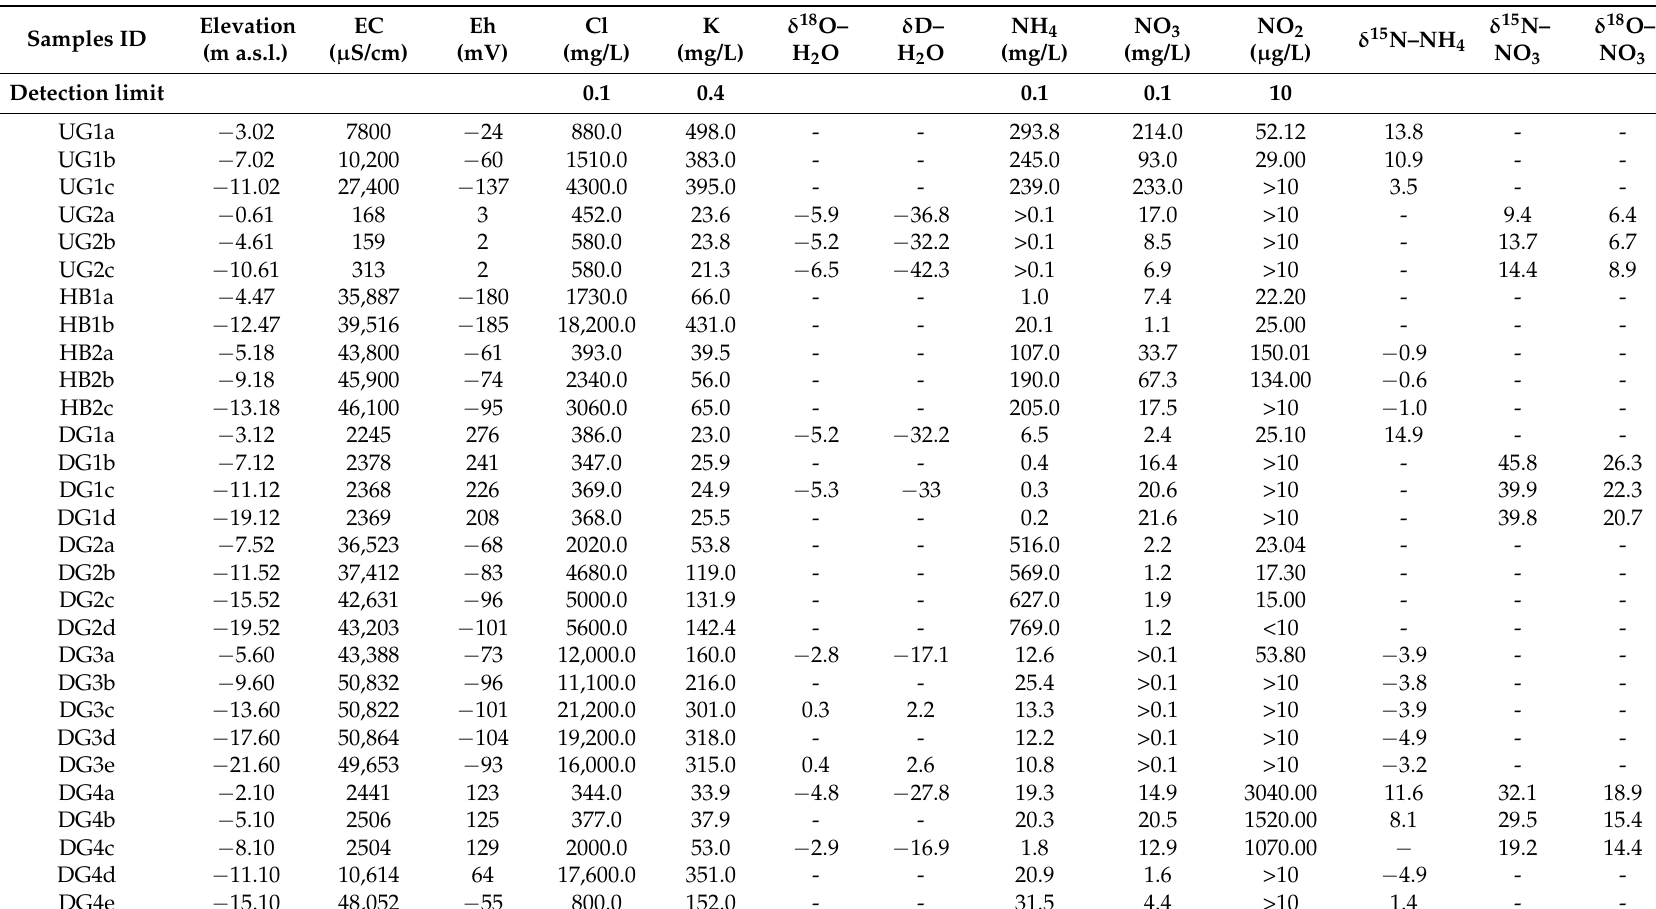
Table 1. Physical–chemical parameters, major ion concentration values, groundwater and nitrogen-stable isotopes results for groundwater sampled via MLS monitoring wells (November 2011–April 2012), rainfall and urban water. Alphabetical order indicates increasing sampling